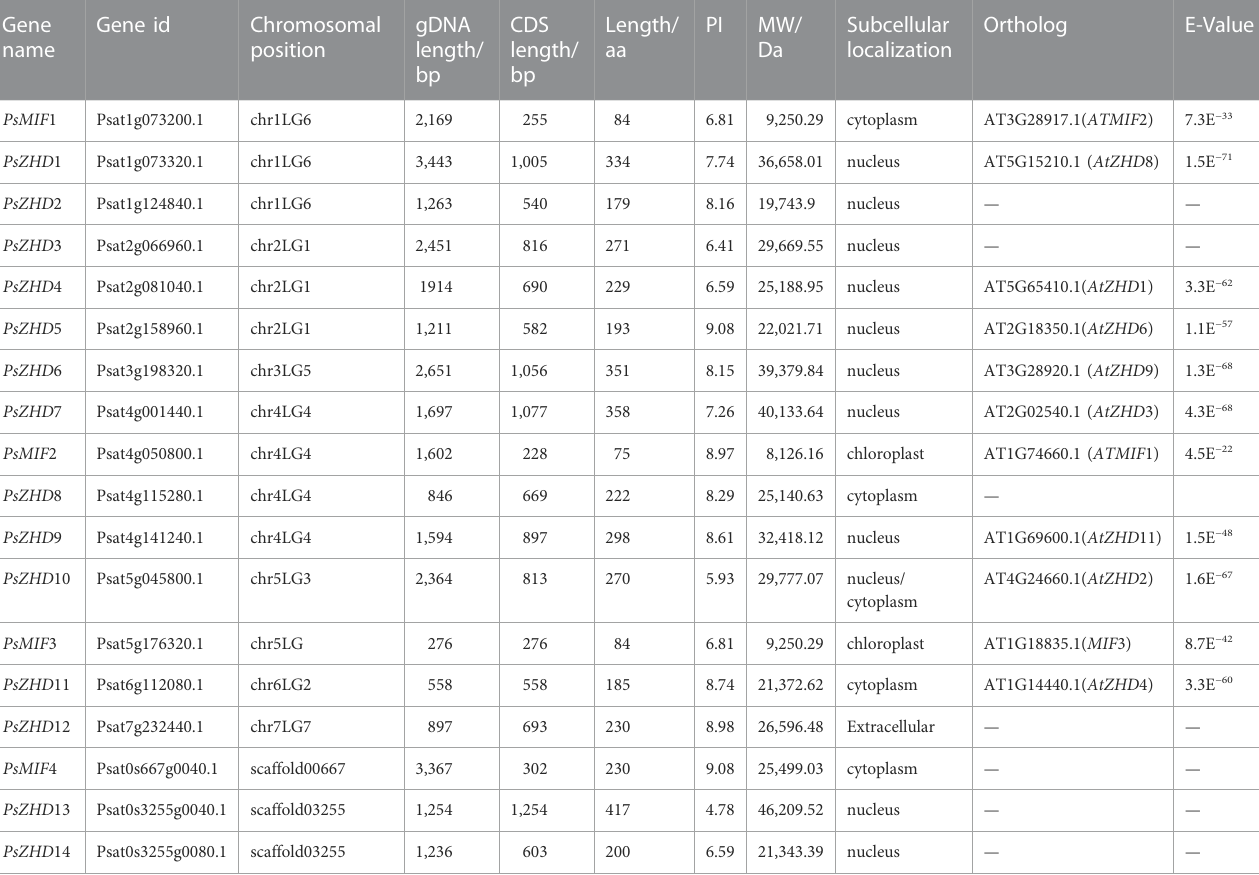
TABLE 1 Detailed information for the ZF-HD gene family in Pisum